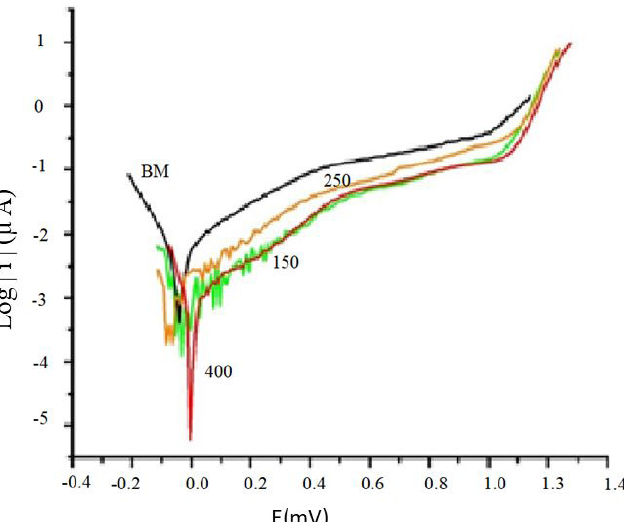
Figure 8. Comparison of polarization curves of the fusion zone (FZ) for different inter-pass temperatures (150 o C, 250 o C, and 400 o C), with the base metal as reference.